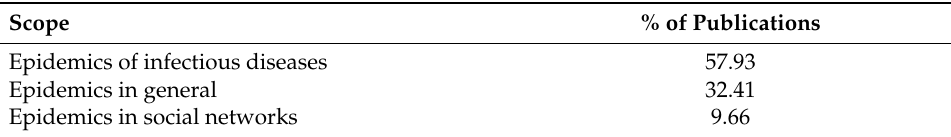
Table 5. Percentage of publications by field of